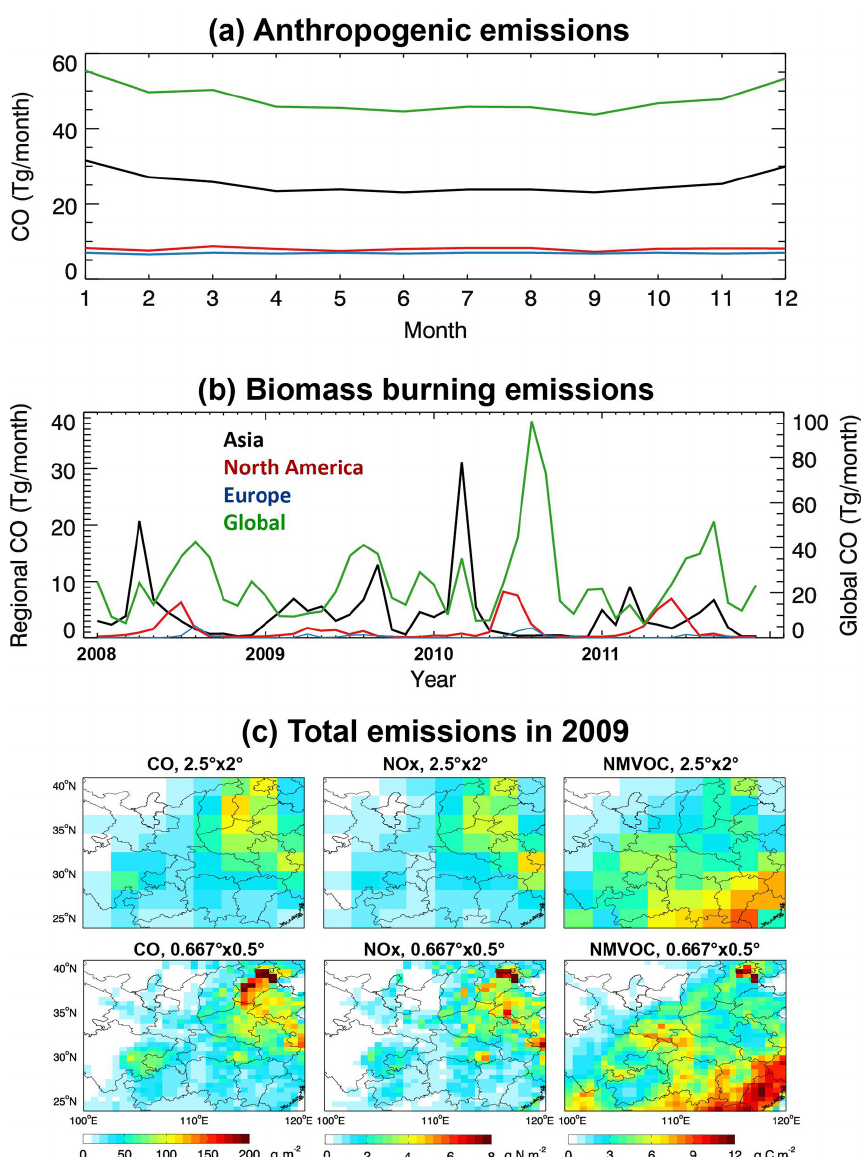
Figure 3. (a) Monthly anthropogenic (fossil + biofuel) emissions of CO within the nested or global model domains; emissions are unchanged from one year to another. (b) Monthly biomass burning emissions of CO over 2008–2011 within the nested or global model domains. (c) Spatial distributions of CO, NO x , and non-methane volatile organic compounds (NMVOCs) emissions from all sources in 2009 over eastern China on the global vs. nested